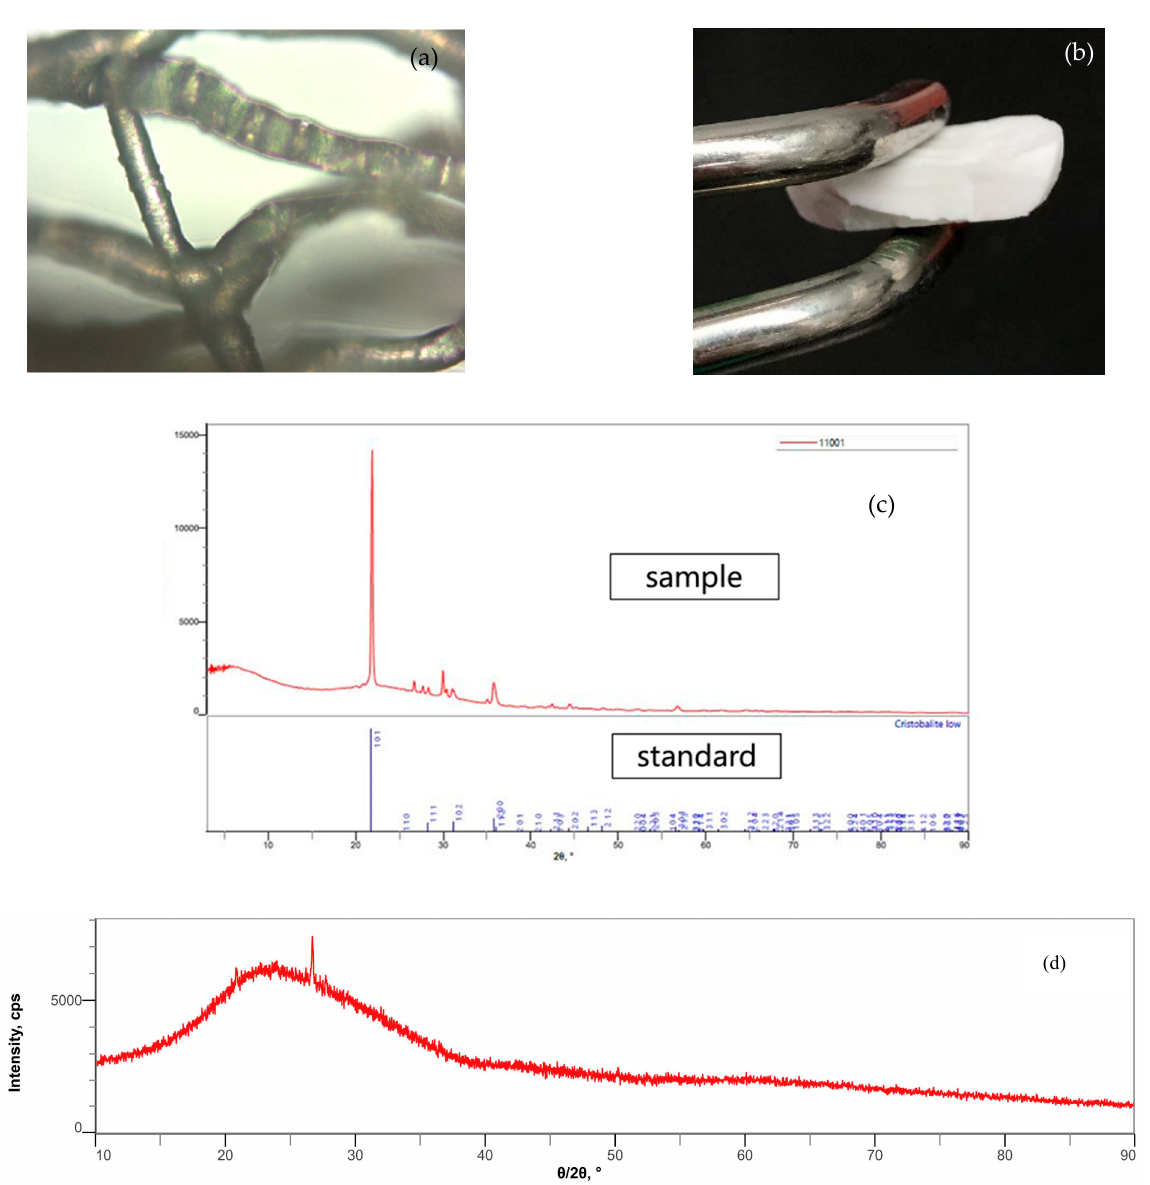
Figure 2. The characteristics of glass fiber waste with and without heating treatment: ( a ) The image of sample (without grinding) heated at 800 °C for 2 h; ( b ) the image of sample (with grinding) heated at 800 °C for 2 h; ( c ) XRD spectrum of glass fiber waste heated at 800 °C for 2 h; ( d ) XRD spectrum of glass fiber waste without heating treatment.